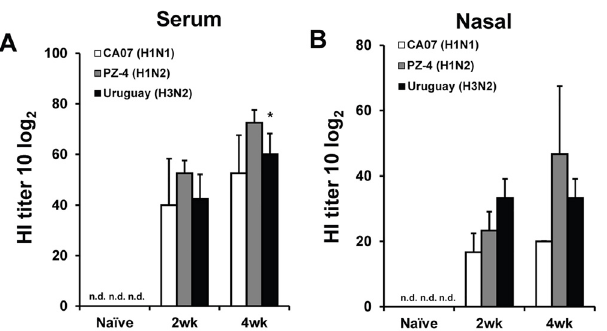
Fig 1. Eyedrop vaccination with live attenuated influenza vaccine (LAIV) elicits immunological responses in ferrets. Three groups of ferrets (n = 3) were administrated with two doses of CA07 (H1N1) or PZ-4 (H1N2) or Uruguay (H3N2) LAIV eyedrops, respectively. Levels of anti-LAIV HI titers were measured by HI assay in serum (A) and nasal lavage (B) samples, respectively, two weeks after the first (2wk) and the second (4wk) vaccination. * p < 0.05 compared with the findings in the 2 weeks group; n.d., non-detected. Statistical analyses were conducted by the student ’ s t-test